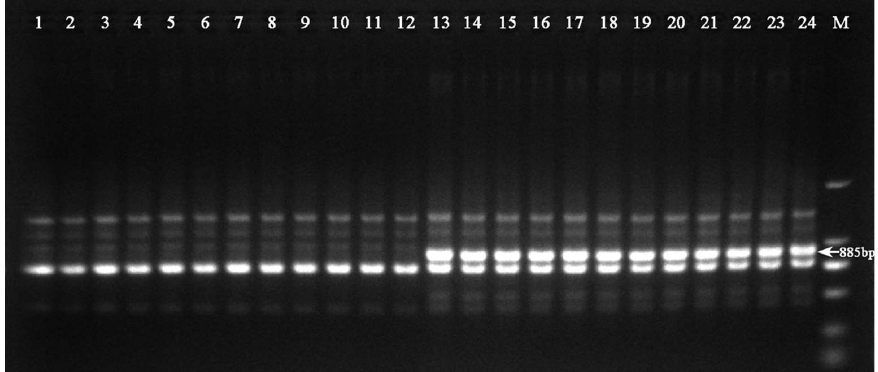
Figure 2. Amplification profile of RAPD primer D15 in H. rhamnoides genotypes. The arrow indicates 885 bp, lanes 1–12: male, lanes 13–24: female. M, DNA Marker DL2000 (Takara, Dalian, China).